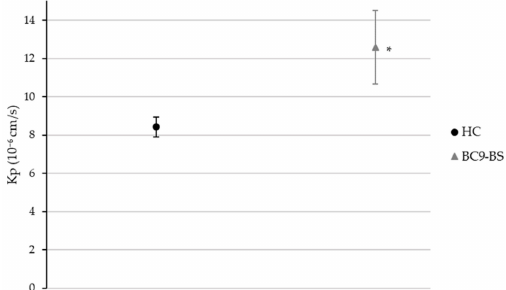
Figure 6. HC permeability across the sheep nasal mucosa in the absence and presence of BC9-BS at a concentration below the CMC. Data are expressed as means ± SD, n = 3. Significance indicated by * = p < 0.05 with respect to the